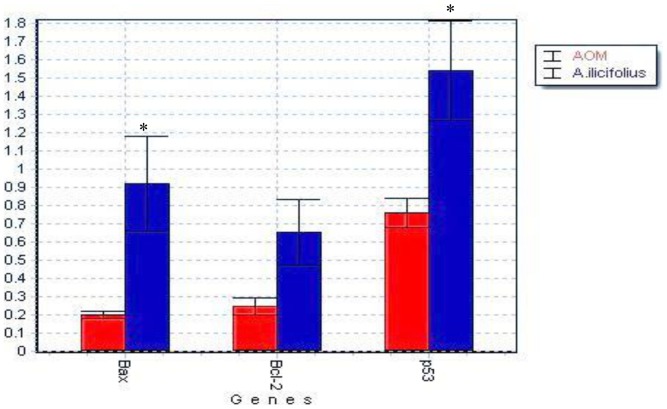
Changes in the mRNA Expression Levels of Bax, Bcl-2 and p53.Data are presented as the mean ± SEM, P<0.05.